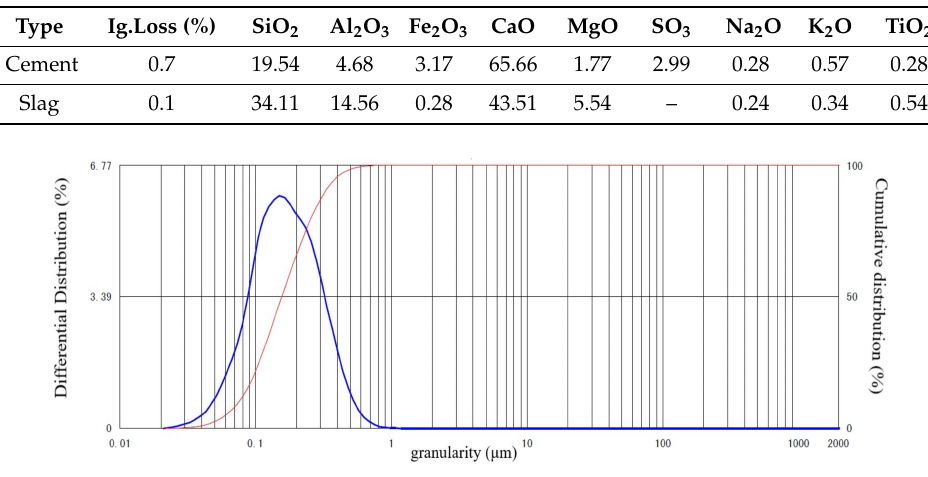
Figure 1. The granularity distribution of blast furnace slag used in this